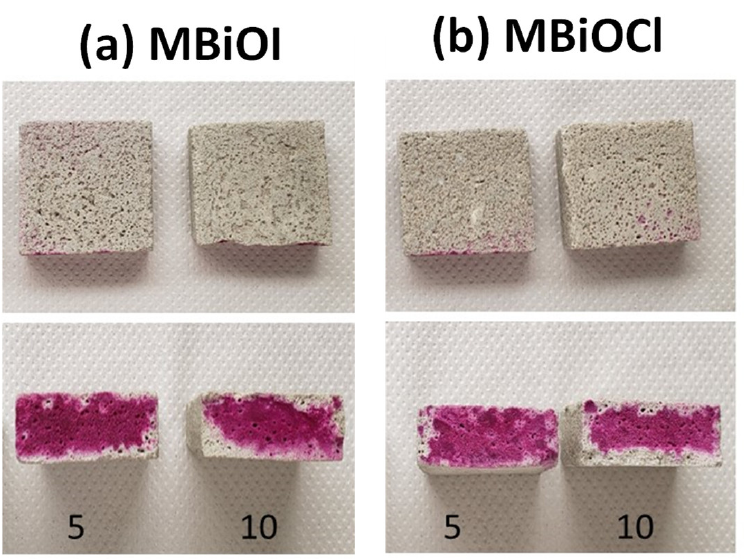
Figure 11. Carbonation test according to the phenolphthalein indicator of photocatalytic mortars with different contents of BiOX (5 and 10%) exposed to real weathering for 13 months.